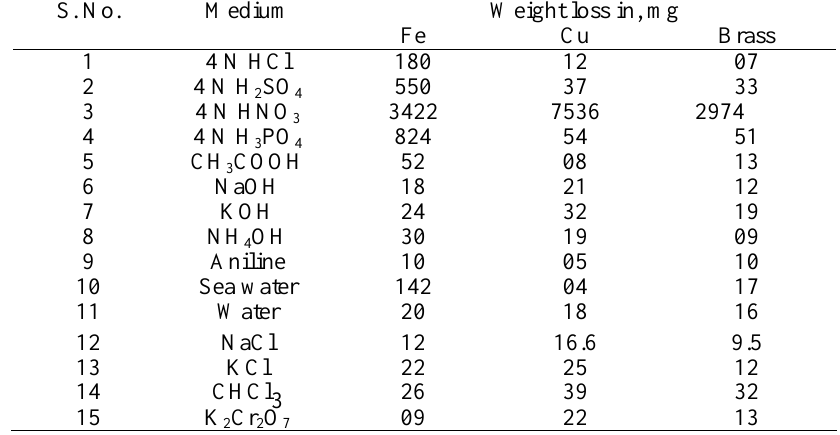
Table 1. Comparative corrosion study of metals and alloys in different medium in terms of weight loss (mg) parameter S. No.